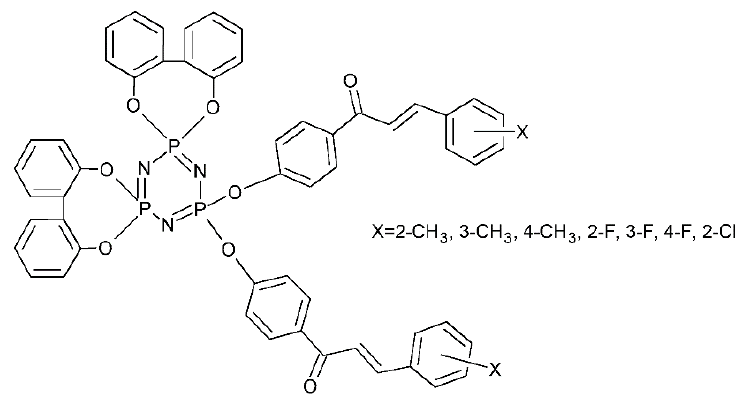
Figure 11. Chalcone-cyclophosphazene derivatives.